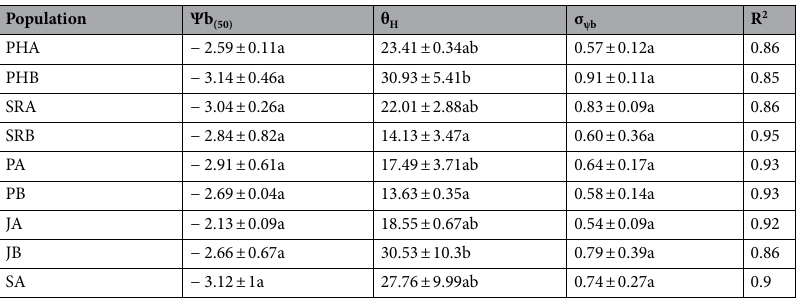
Table 2. Estimated parameters of the hydrotime model: ψb (50) , mean base water potential (MPa); θ H , hydrotime (MPa d); σ ψb , standard deviation of base water potential for each population; and mean R 2 of the observed and predicted germination. Different letters indicate significant differences (Tukey, p <